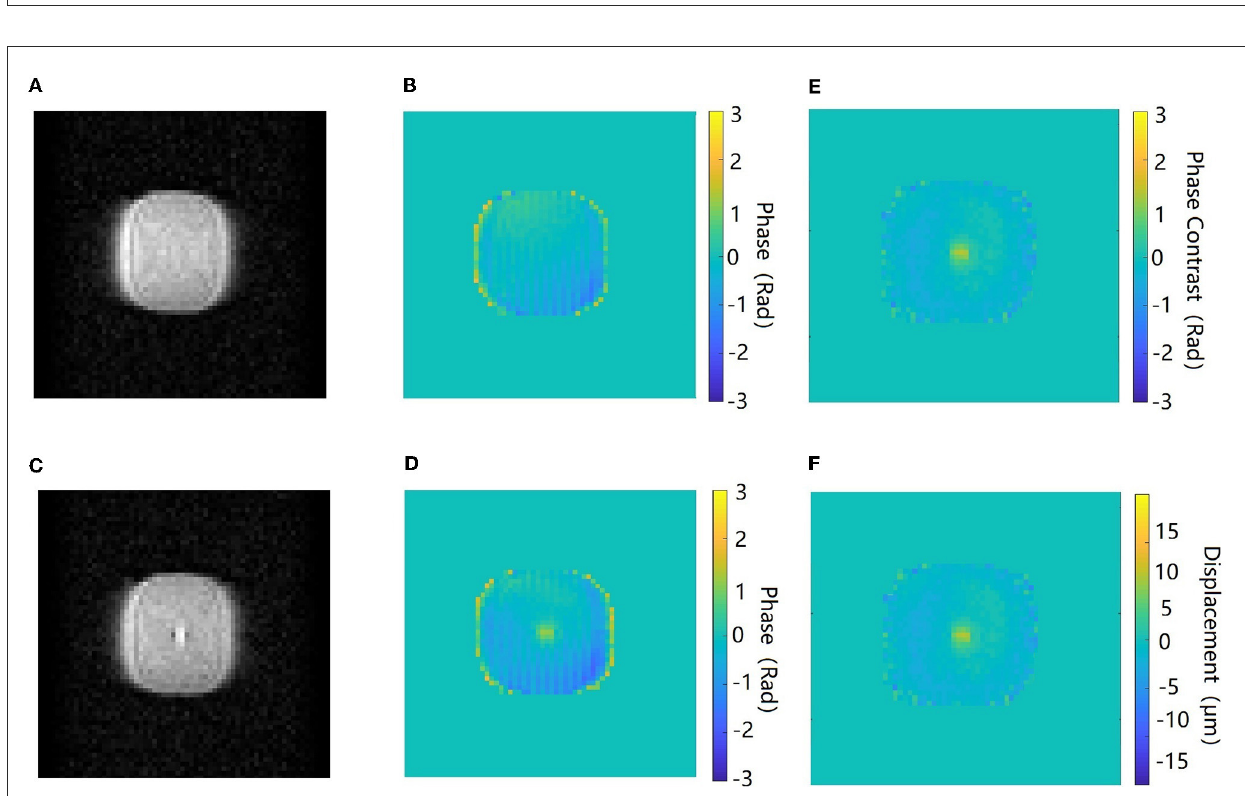
FIGURE5 Amplitude and phase images acquired in the axial orientation before (A, B) and after (C, D) the ultrasound beam is applied to the target in the agar phantom. The phase contrast map (E) and the corresponding displacement map (F) . The color bar of the phase images and phase contrast map corresponds to a phase interval of π to – π